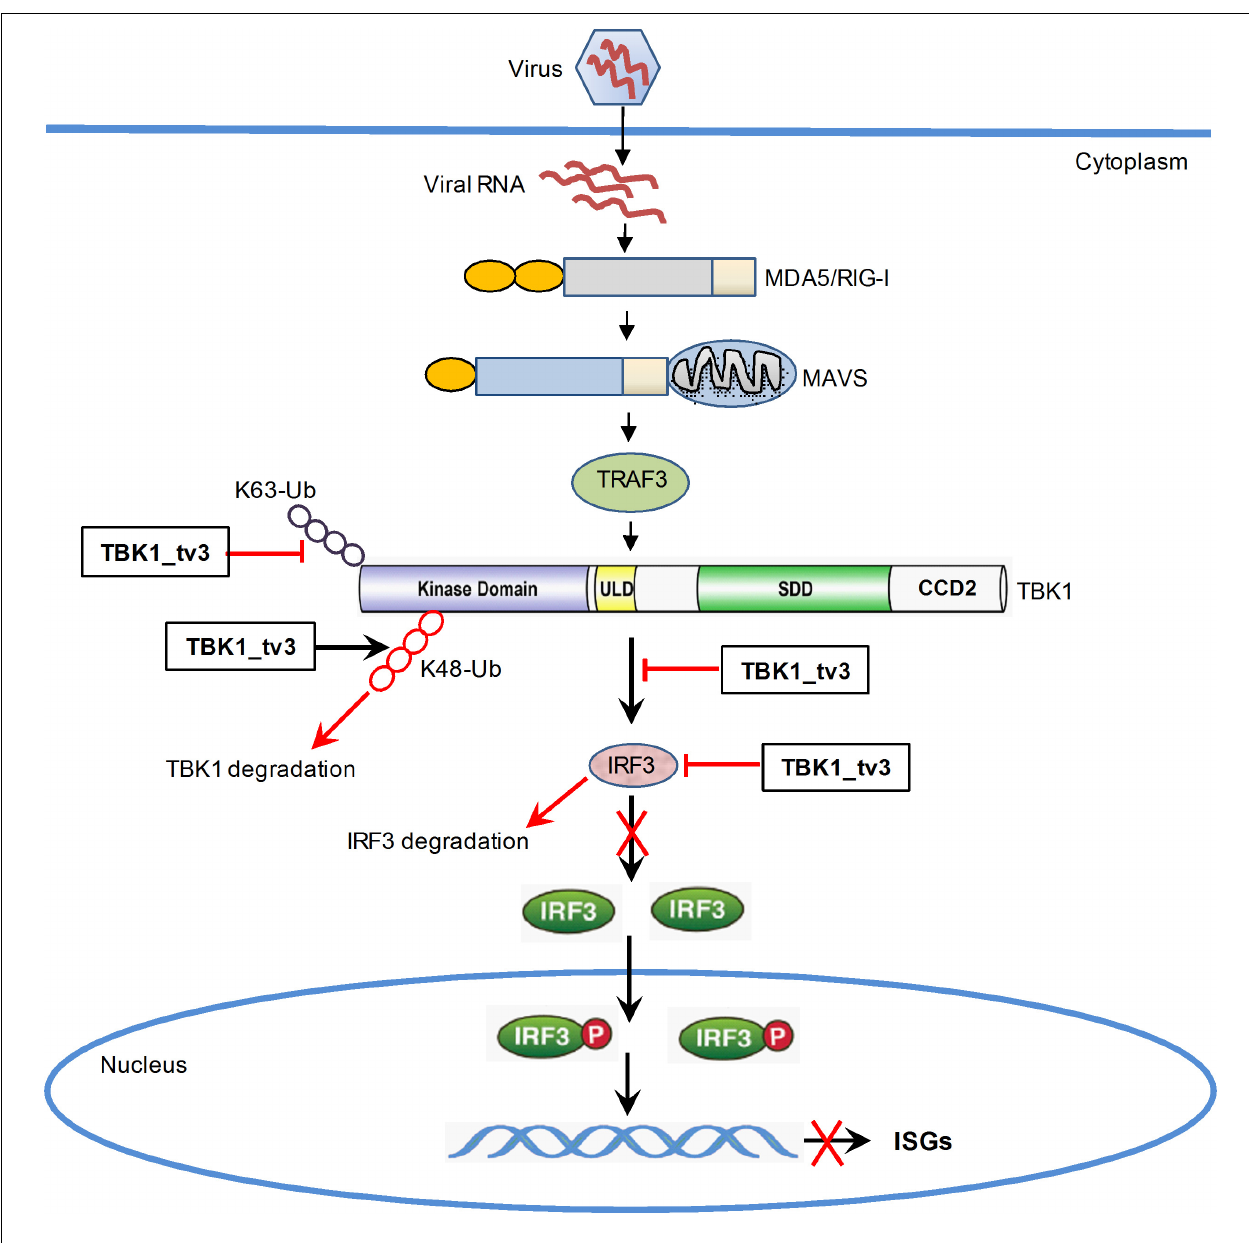
FIGURE 8 | Proposed model illustrating the negative regulation of TBK1_tv3 in the homeostasis of innate immune